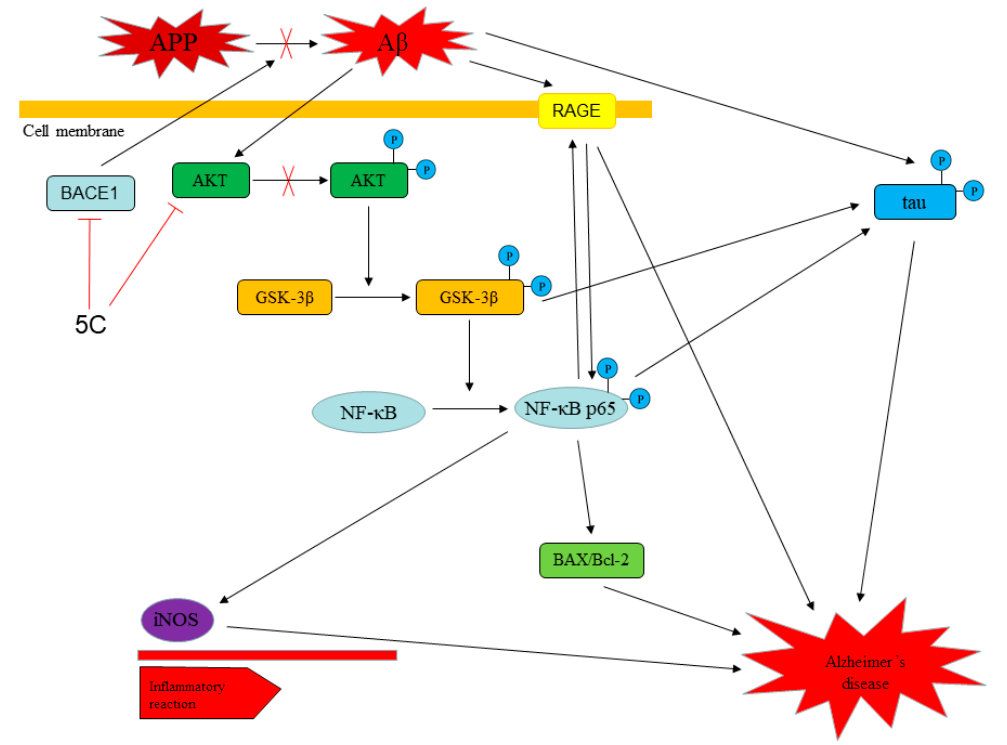
Figure 9. Schematic diagram of potential mechanisms by compound 5c affects the activity of A β 25-35 -induced PC12 cells.